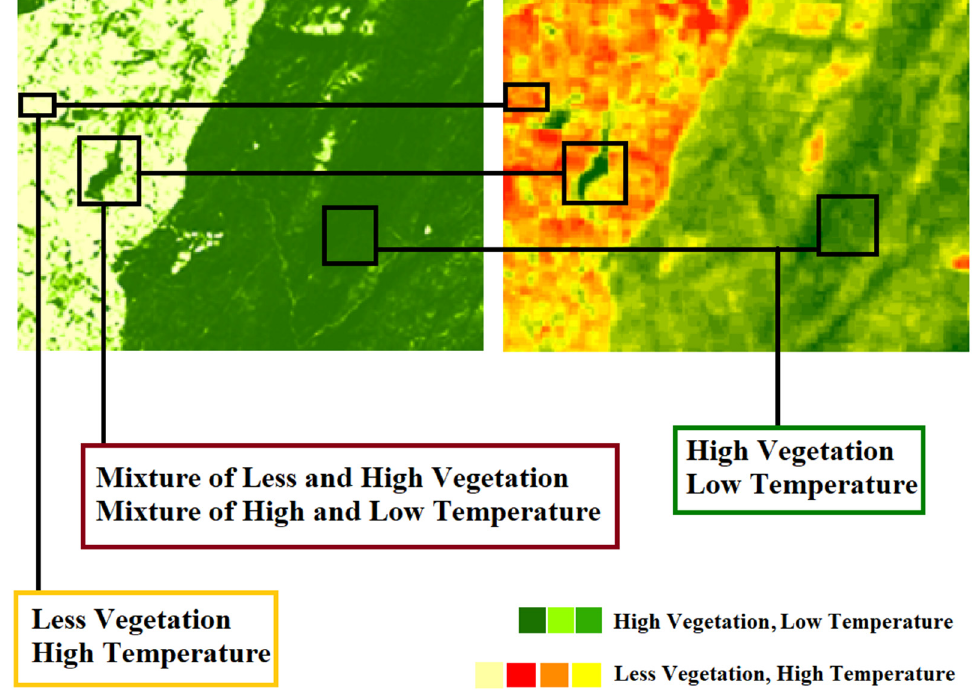
Figure 19. Impact of LST features with the LU/LC classes for Javadi Hills, India. Table 4. LST and LU/LC values for the area of Javadi From the input LU/LC and LST features of 2012 and 2015, we predicted the LU/LC map of 2018 by using the Bi-LSTM model with the tuning of different parameters. The validated result provides good accuracy for our proposed model. We used the inputs of the LU/LC map of 2012 and 2015, along with the predicted LU/LC map of 2018 for pre- dicting the LU/LC map for the year 2021. The short-term prediction was performed till the year 2027 for our study area. The working process of the Bi-LSTM model was ex- plained in Section 3.4. The parameter used during the training process of the Bi-LSTM model is shown in Table 5.